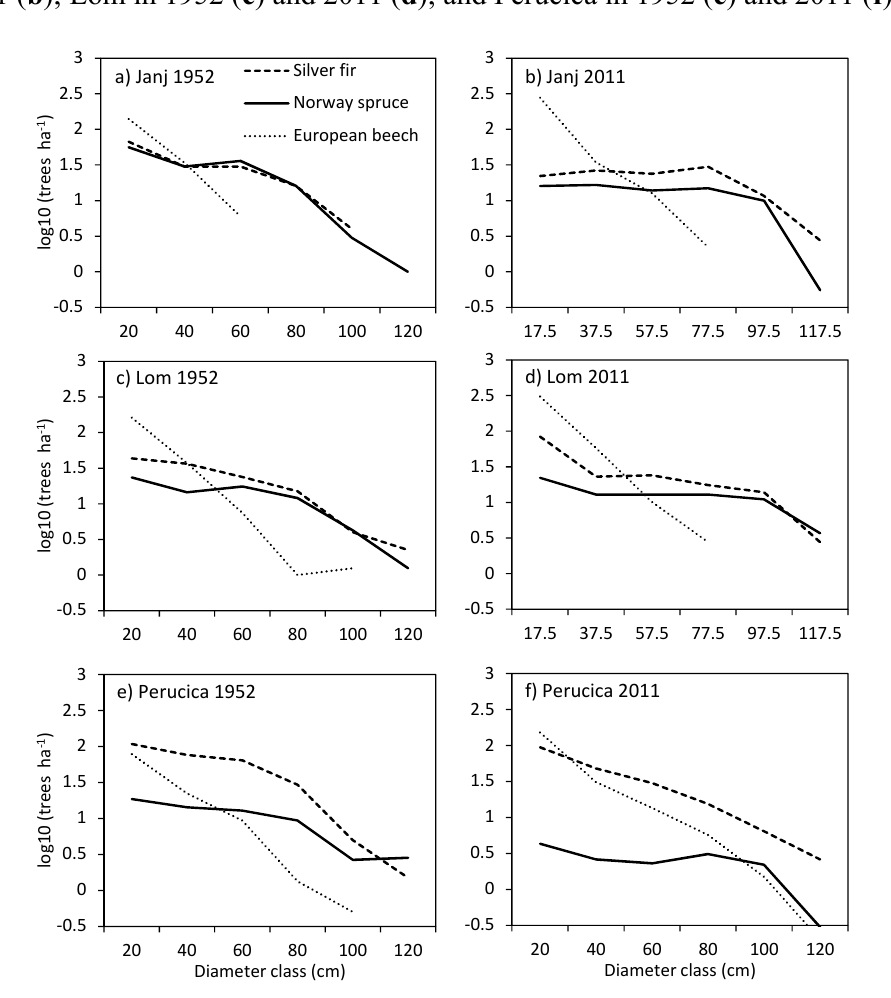
Figure 5. Comparison of diameter distributions for the Janj old-growth forest in 1952 ( a ) and 2011 ( b ); Lom in 1952 ( c ) and 2011 ( d ); and Perucica in 1952 ( e ) and 2011 ( f